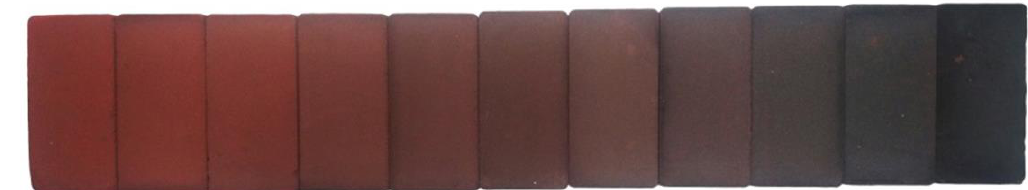
Figure 5. Image of the different families of samples from family 10C0A (left) to family 0C10A (right). In order to determine the color of each sample accurately, the colorimeter was used, giving the following values for the primary colors red, green and blue, as detailed in Table 6. Table 6. RGB color coordinates of the samples conformed by the chamotte and the BBA of the different groups.